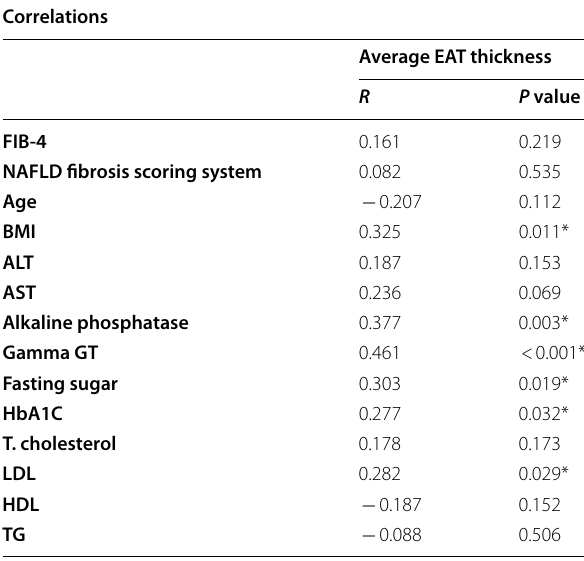
Table 8 Correlations between average EAT thickness and BMI of the patients and their metabolic parameters